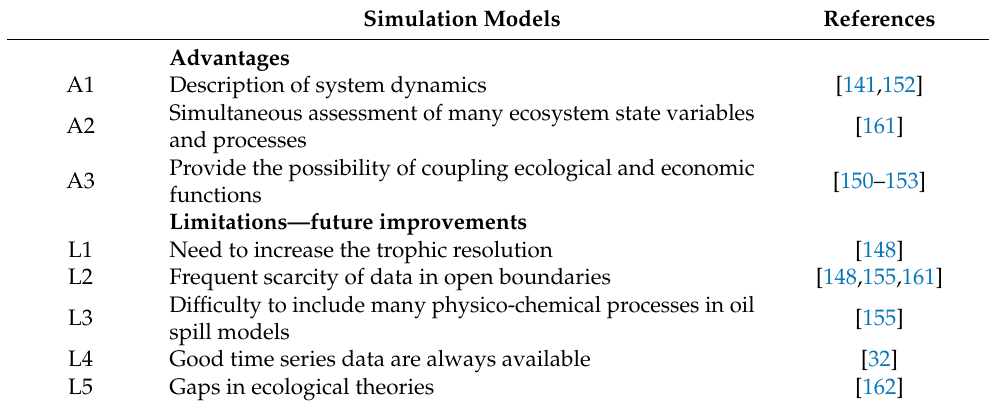
Table 5. Simulation models used in ecological research and policy management purposes: advantages and